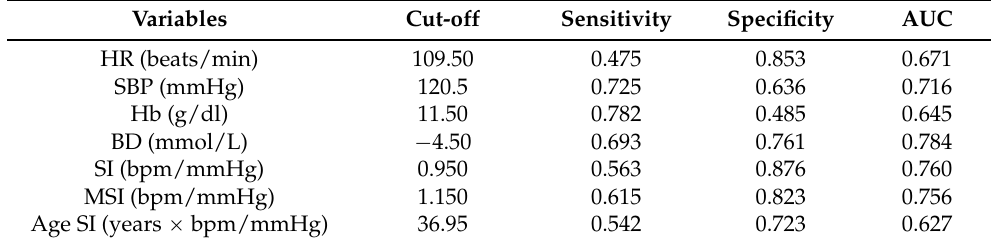
Table 3. Cut-off value and area under the curve of different physiological variables in predicting the requirement for MT.